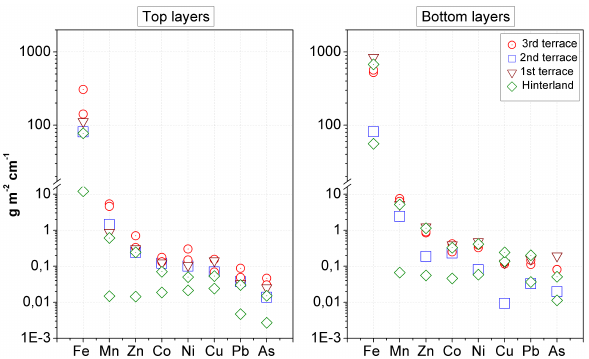
Fig. 2. Volumetric concentrations of trace elements in top and bot- tom soil horizons of investigated sites of the north–south transect in northern Siberia (gm − 2 cm − 1 ) . Symbols with centred dot point out the sites 3T-1 and H-3,